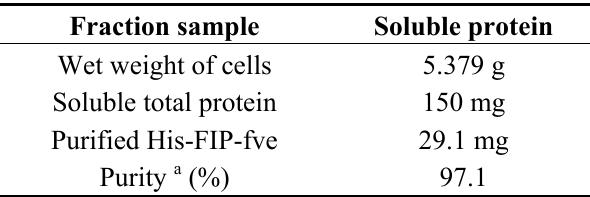
Table 1. Summary of the purification process. a The purity of His-FIP-fve was assessed by densitometry analysis of Tris-Tricine SDS-PAGE. Total protein mass was estimated using a protein assay kit (Pierce) with BSA as a standard. One liter of culture media was used to purify